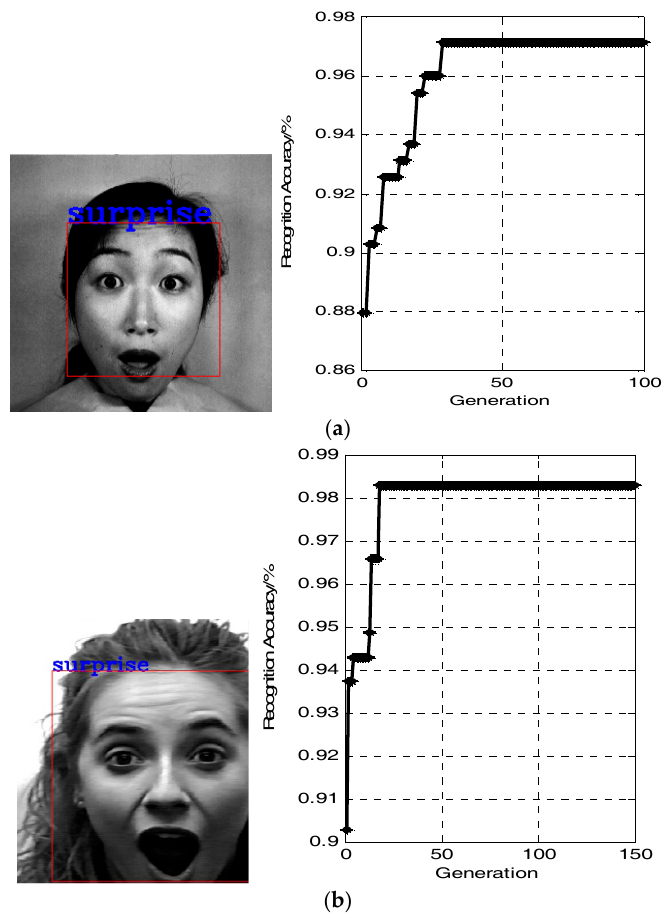
Figure 9. The best record for the surprise expression recognition during the training stage. ( a ) Surprise expression recognition in JAFFE; ( b ) surprise expression recognition in Cohn–Kanade.